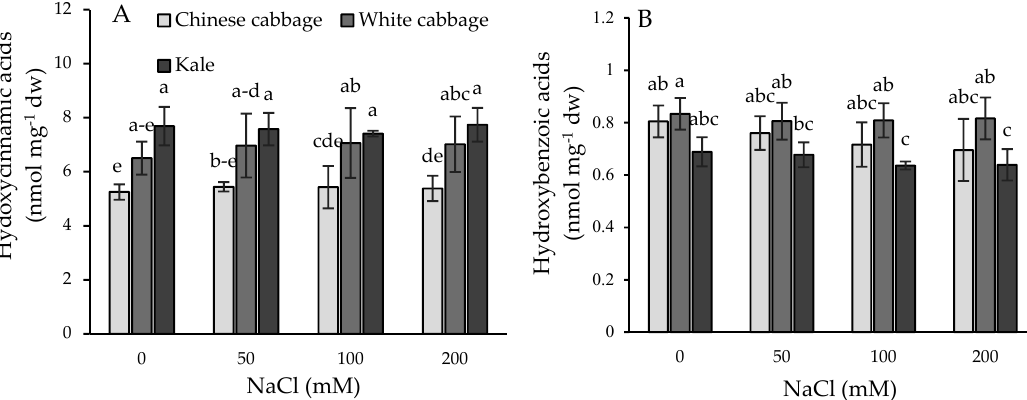
Figure 5. Total hydroxycinnamic acids ( A ) and total hydroxybenzoic acids ( B ) in Brassica seedlings upon salinity treatments (0–200 mM). Data are averages ± SD ( n = 5). Points labeled with different letters differ significantly at p < 0.05.